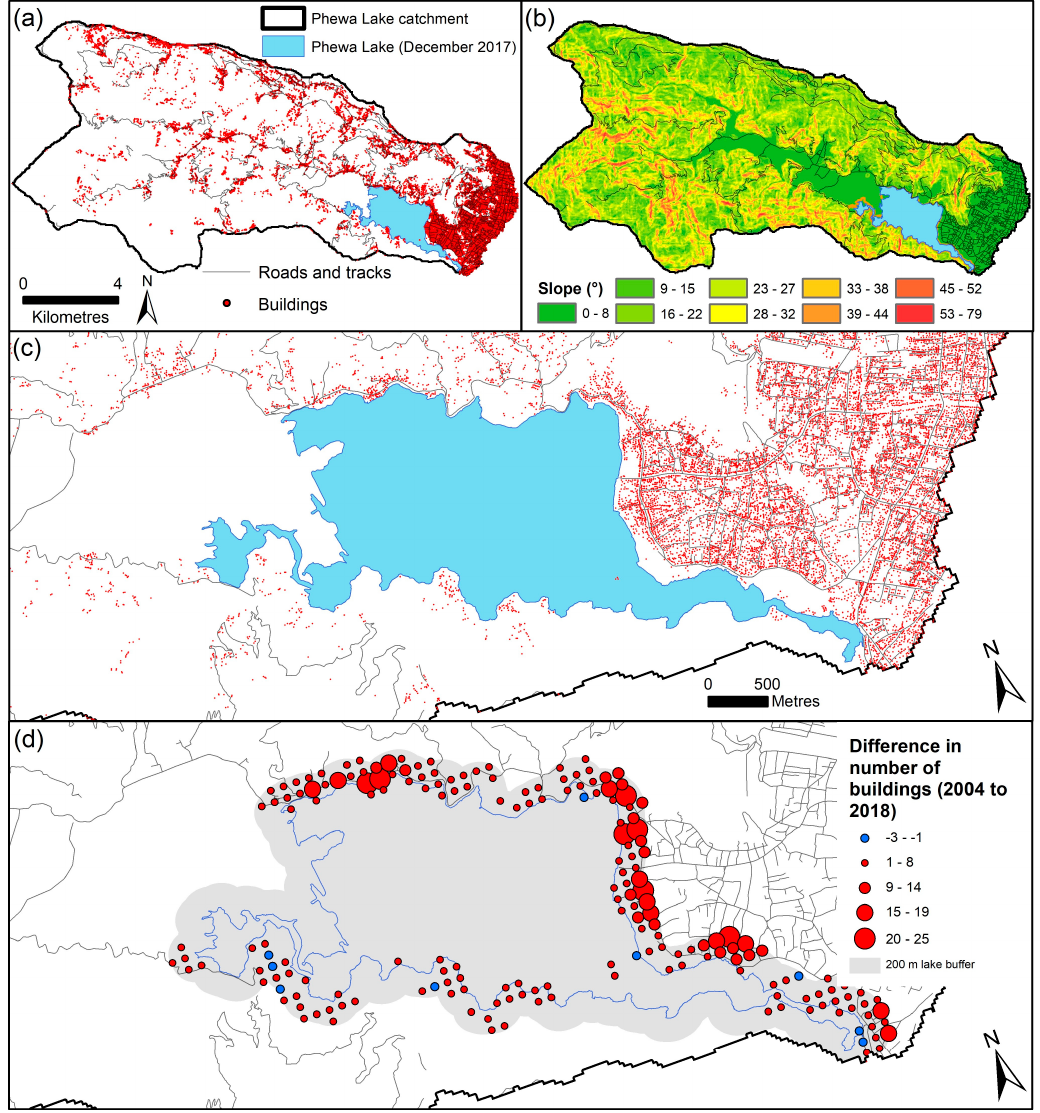
Figure 9. ( a ) Tracks, roads, and buildings in the Phewa Lake catchment. ( b ) Catchment slope derived from the Shuttle Radar Topography Mission DEM. ( c ) Enlarged view of the lakeshore. ( d ) Difference in the number of buildings within 200 m of the lakeshore, aggregated to a 1 km 2 grid (2004–2018). Table 2. Buildings located in areas of potential landslide activity.